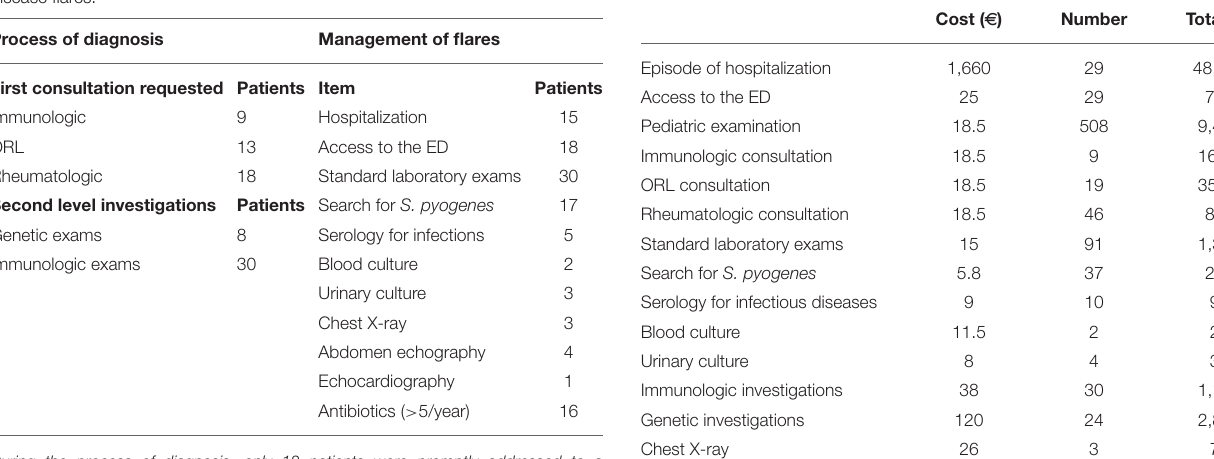
TABLE 3 | Direct costs related to PFAPA